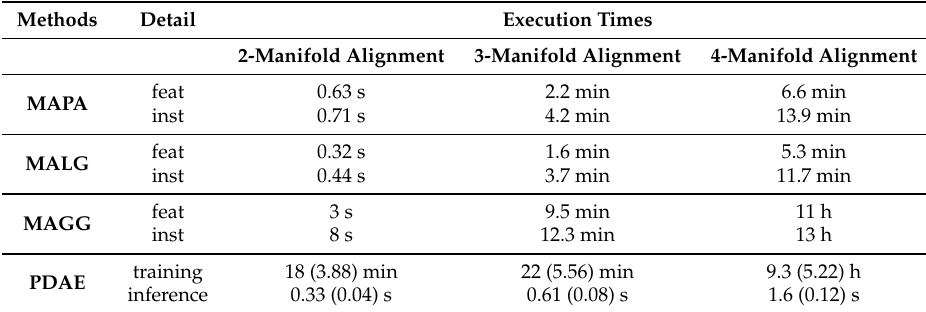
Table 6. Shown are the execution times of the different manifold alignment methods when processing our data. The dataset sizes were 1296 × 6, 1728 × 9, and 20,736 × 11 for the 2-, 3- and 4-manifold data, respectively. The training times of the PDAE were recorded for 10,000 epochs and averaged over five runs starting from different initial weights. Standard deviations are in parenthesis. The other methods did not involve randomness, and their execution times remained the same in repeat